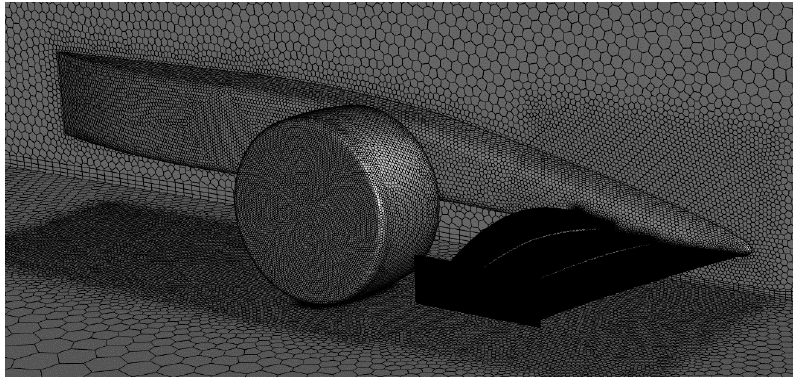
Figure 3. Mesh overview. Figure 3. Mesh